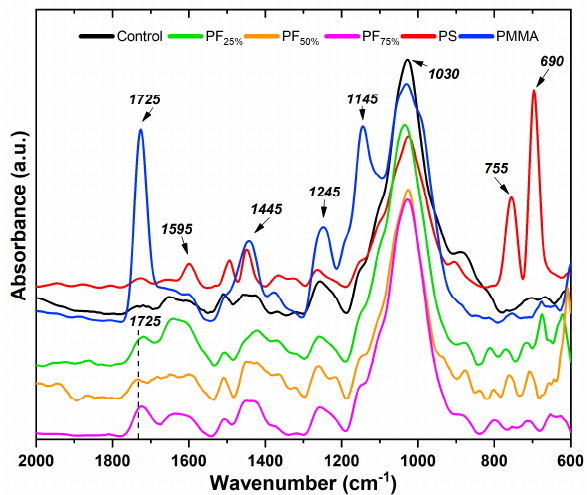
Figure 1. FTIR spectra for control and treated pine woods. Where PF 25% is 25% of poly (furfuryl alcohol), PF 50% is 50% of poly(furfuryl alcohol), PF 75% is 75% of poly (furfuryl alcohol), PS is poly (styrene) and PMMA is poly(methyl methacrylate).